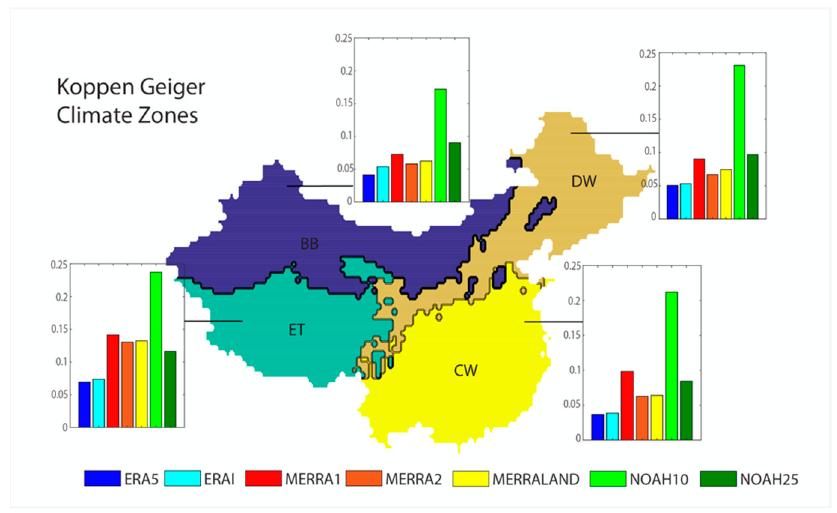
Figure 3. Triple Collocation Analysis (TCA) RMSE results over the different Koppen Geiger climate zones over China for the models.